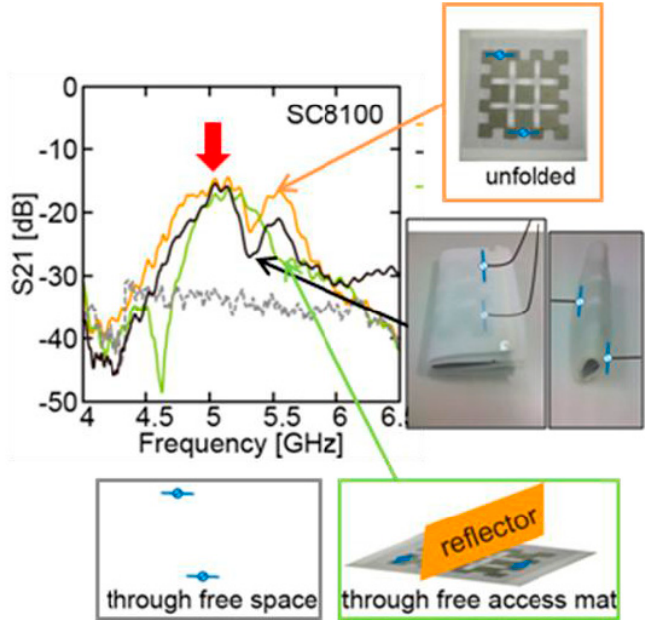
Figure 8. Transmission characteristics of flexible structure two-dimensional transmission line.